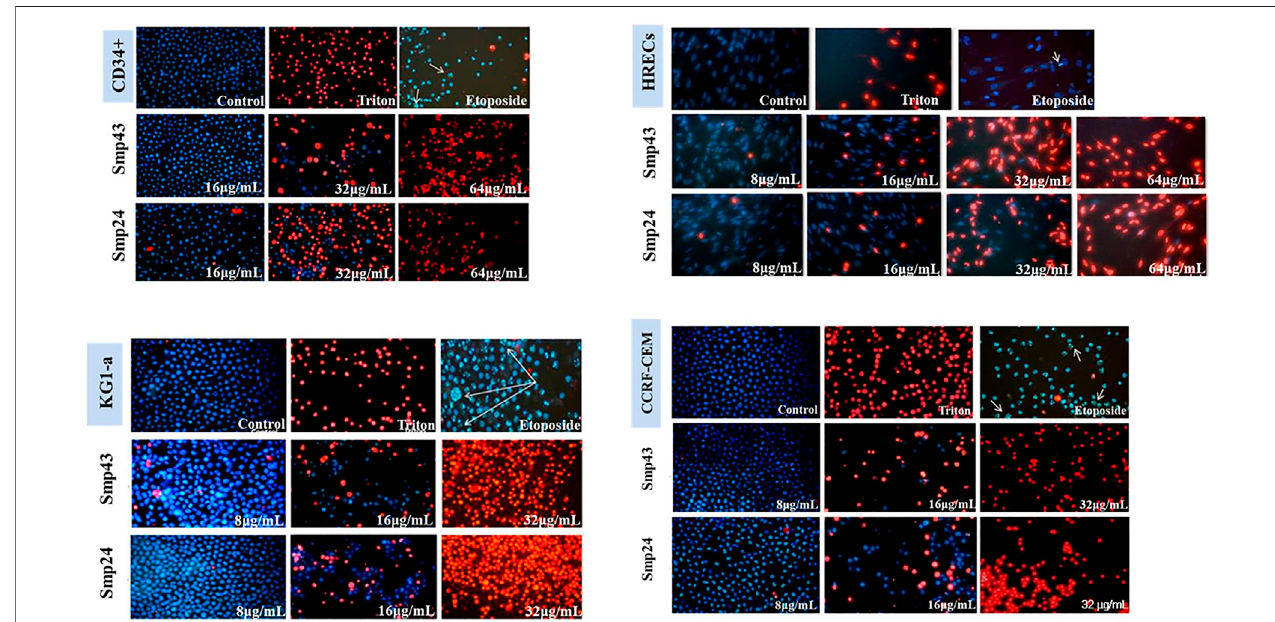
FIGURE 1 | Changes in nuclear morphology of the non-tumour (CD34 + and HRECs) and tumour (KG1-a and CCRF-CEM) cell lines treated with different concentrations of Smp24 or Smp43 (8 – 256 μ g/ml) showed signi fi cant increase in PI stain uptake in a concentration dependant manner (20X).